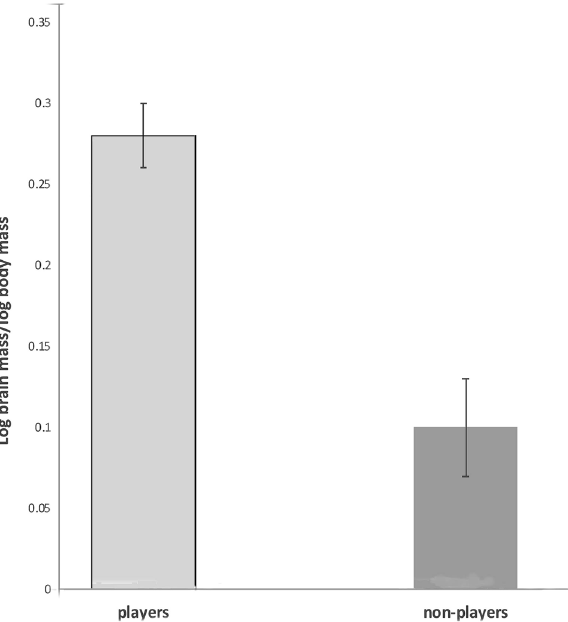
Figure 3. Log of brain mass relative to log of body mass in species that perform play versus those that do not play. The difference is significant ( p = 0.0001; see text for details).